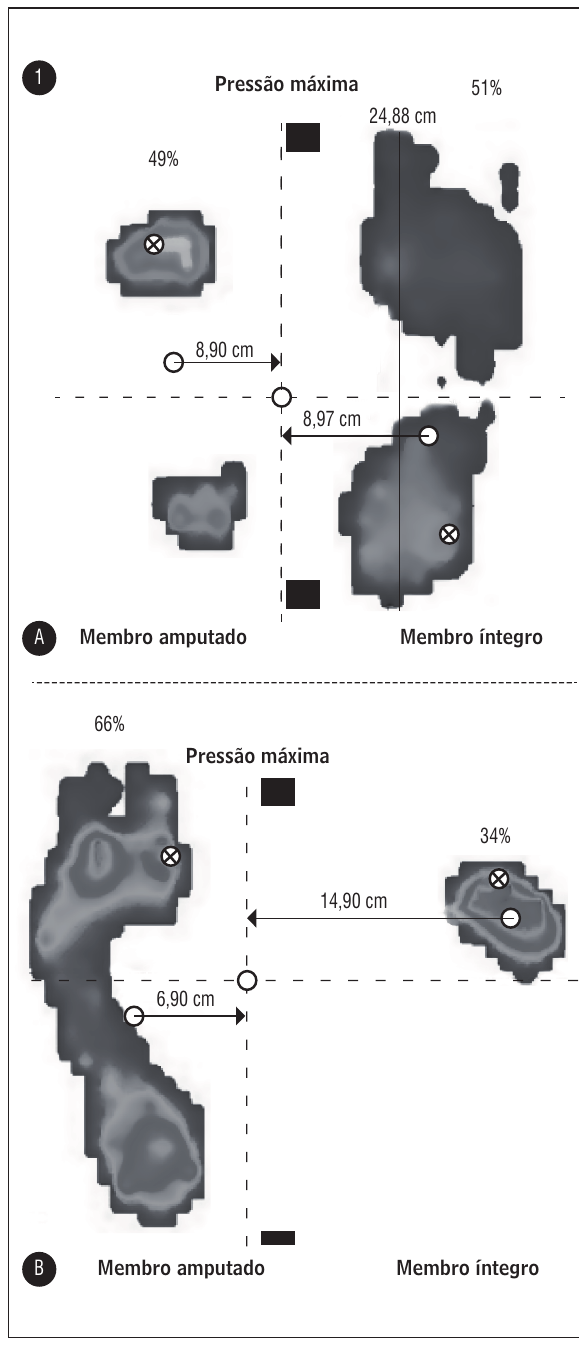
Figura 1 - Representação da impressão plantar de dois indi- víduos amputados no